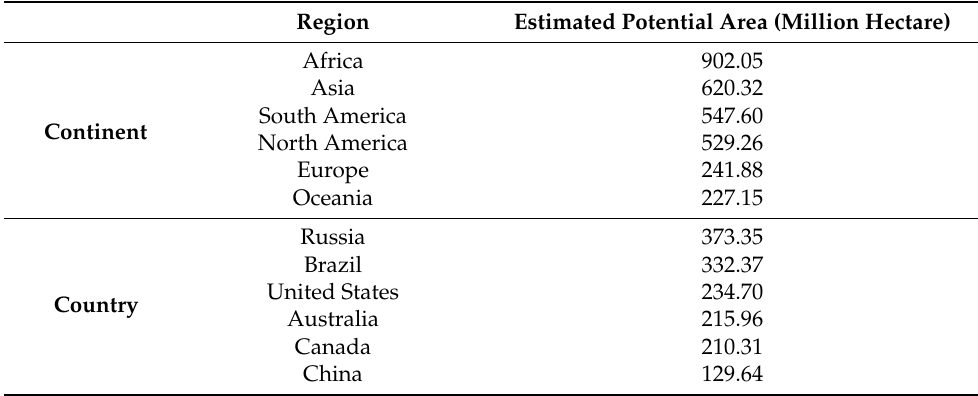
Table 2. Potential marginal land resources suitable for giant silvergrass in major global regions and the countries with an area of suitable land > 100 million